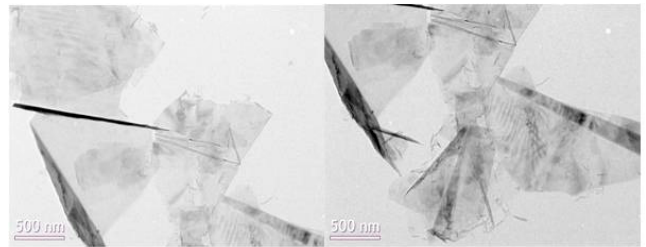
Figure 10. TEM images of the ground Figure 9. TEM images of the ground GN.